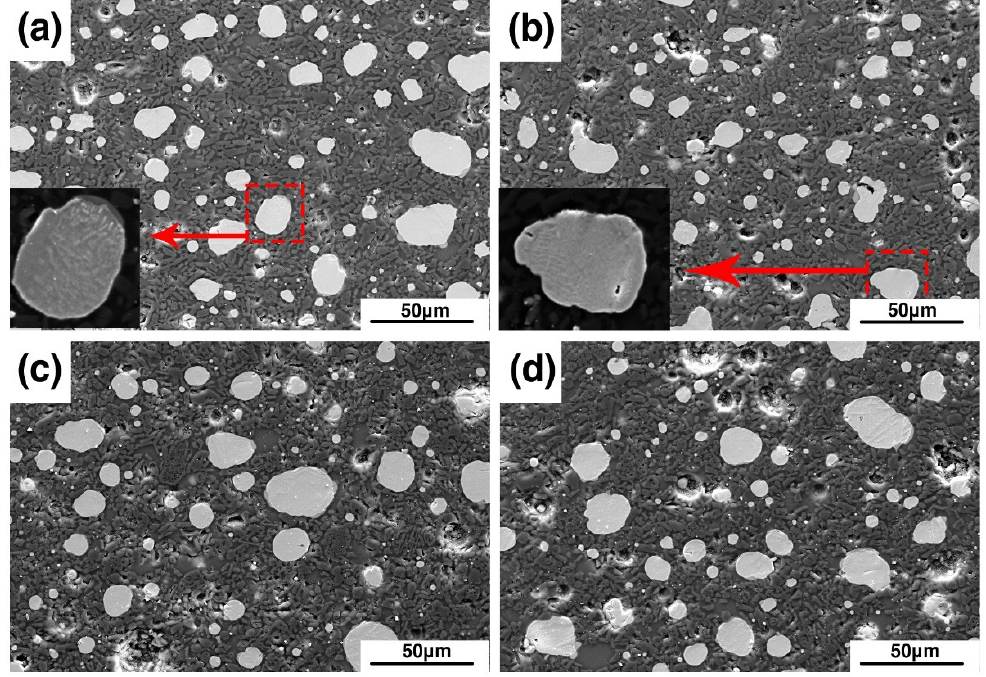
Figure 4. SEM images of samples B1 ( a ), B2 ( b ), B3 ( c ), and B4 ( d ).